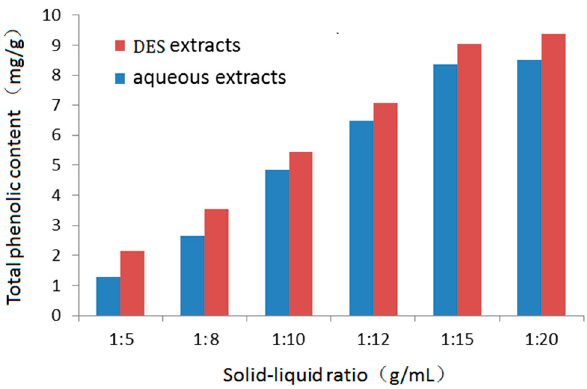
Figure 3. Effect of solid-liquid ratio during homogenate-assisted extraction on total phenolic content.